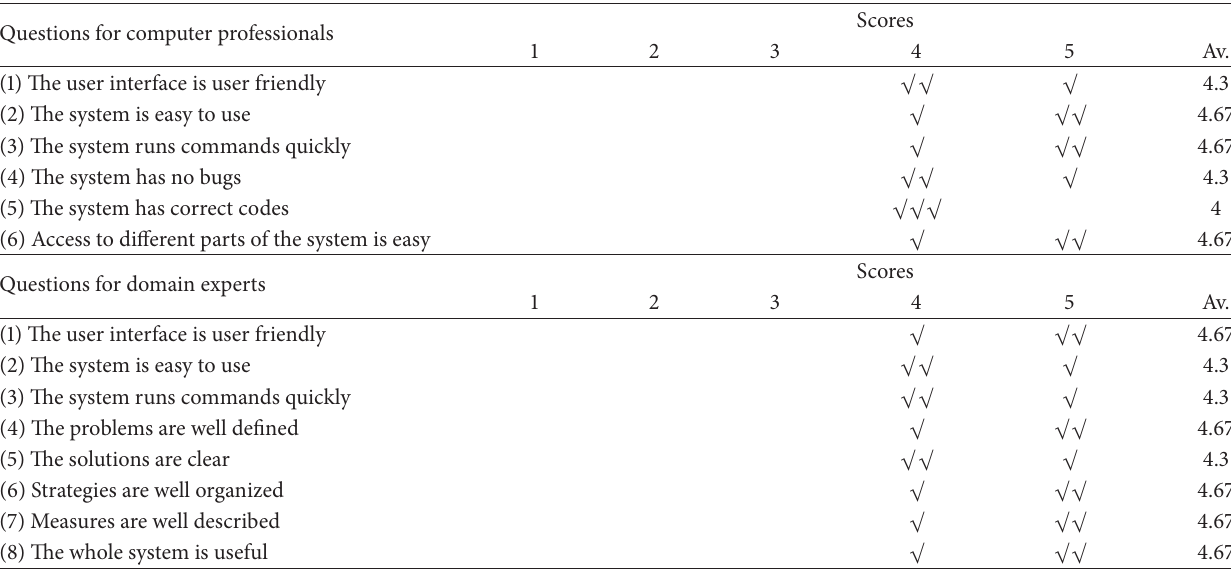
Table 7: Experts’ responses to the system verification